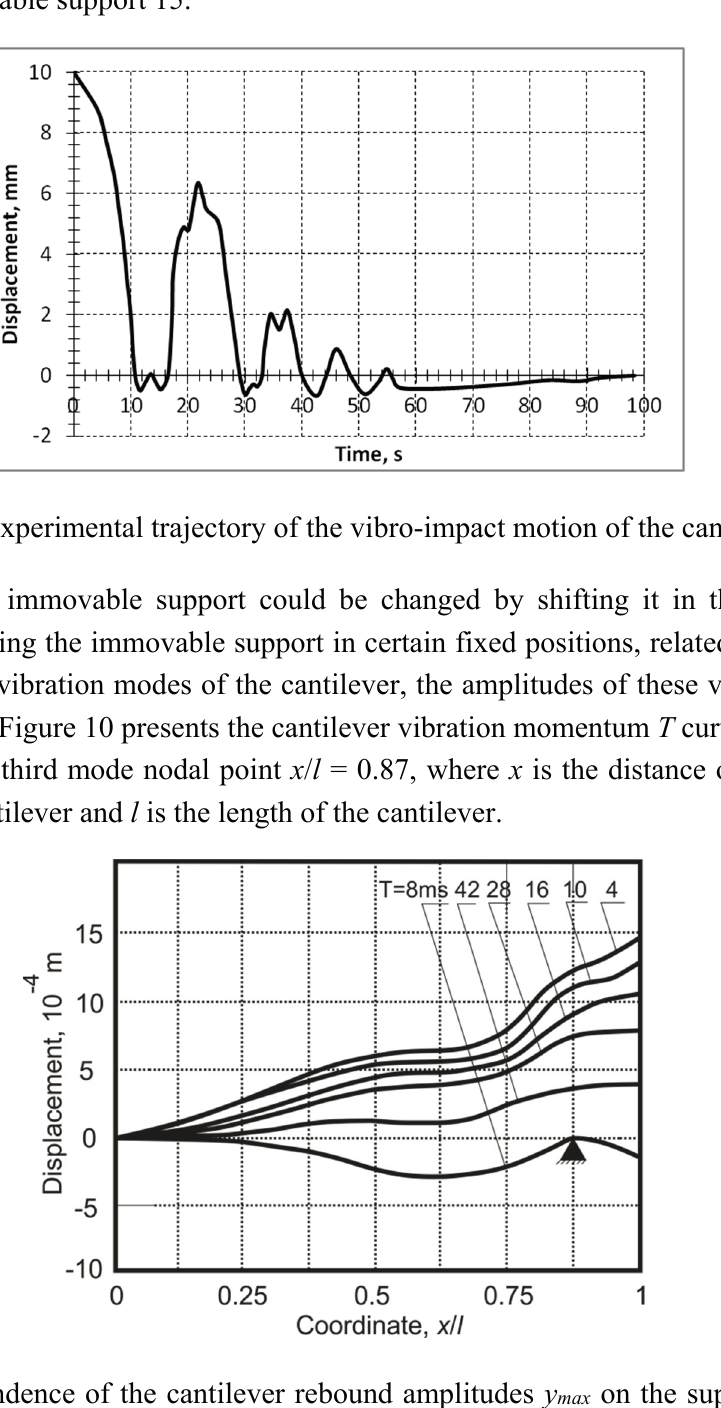
Figure 10. Dependence of the cantilever rebound amplitudes y max on the support position x / l at fixed time moments T after